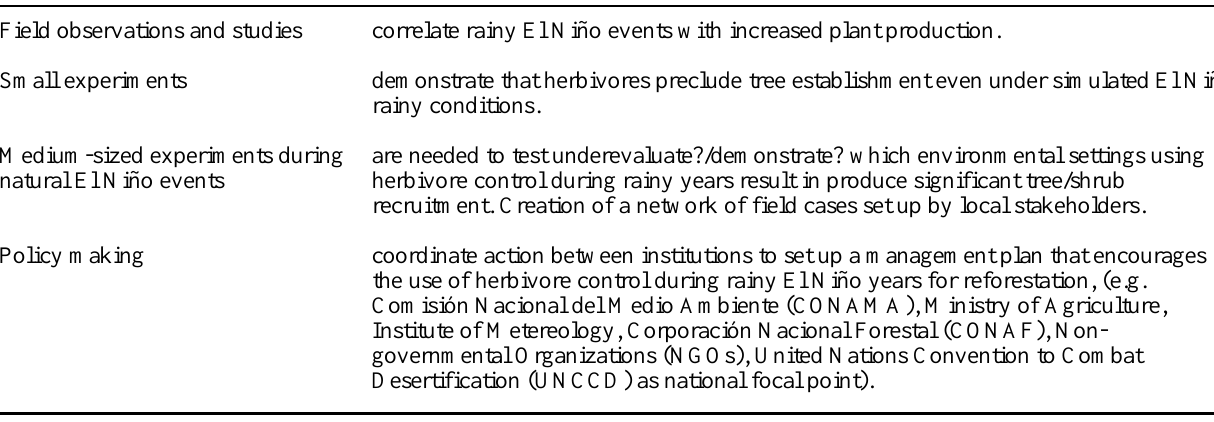
Table 1 . Stages in El Niño experiment. Field observations and studies correlate rainy El Niño events with increased plant production. Small experiments demonstrate that herbivores preclude tree establishment even under simulated El Niño rainy conditions. Medium-sized experiments during are needed to test underevaluate?/demonstrate? which environmental settings using natural El Niño events herbivore control during rainy years result in produce significant tree/shrub recruitment. Creation of a network of field cases set up by local stakeholders. Policy